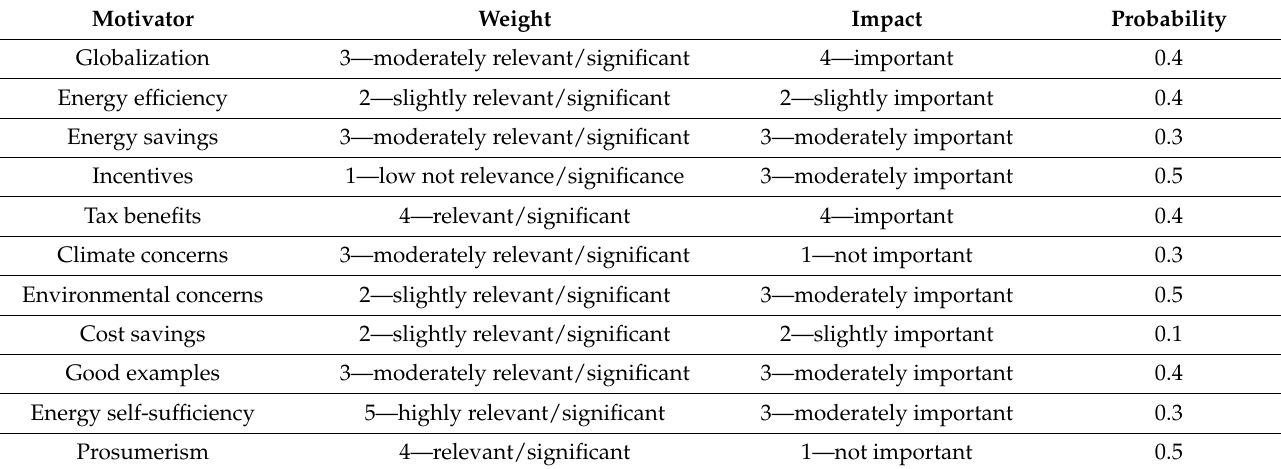
Table 4. Interface for selecting the weight, impact, and probability